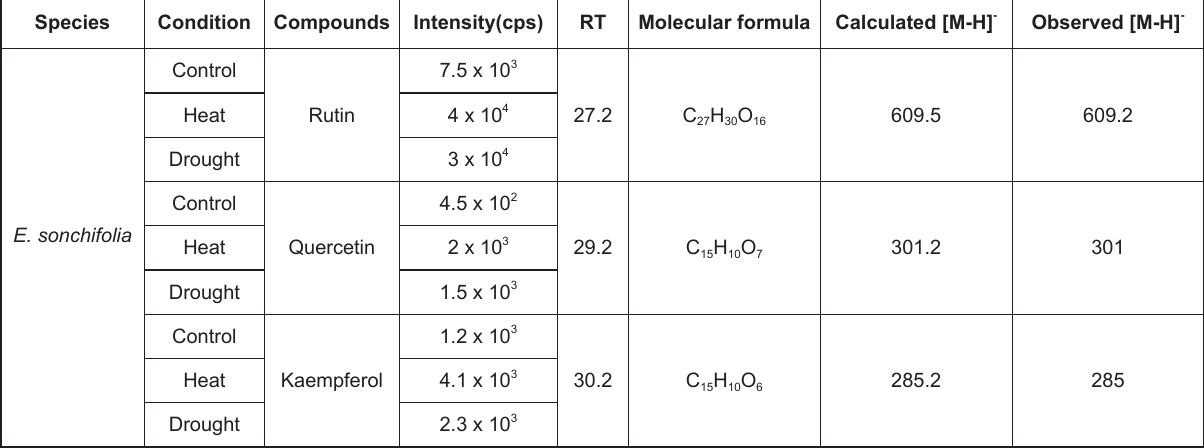
Table 1. LC-MS analysis of rutin, quercetin, and kaempferol in E. sonchifolia under heat-stressed and drought-stressed